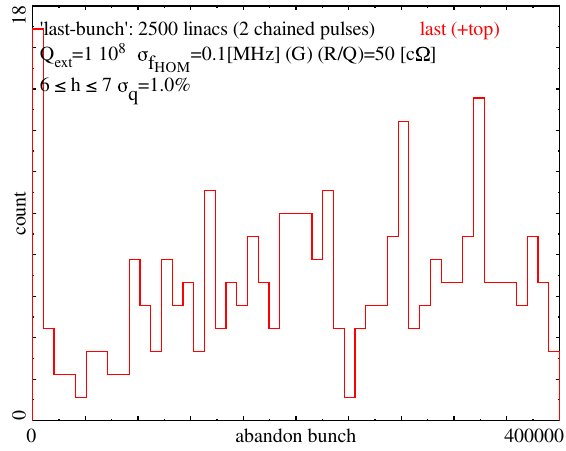
FIG. 18. (Color) Histogram of the last bunch before abort [0– 400 000, 50 bins] for Q ext ¼ 10 8 over 2500 different HOM setups (5000 pulses); conditions as in Fig. 8.